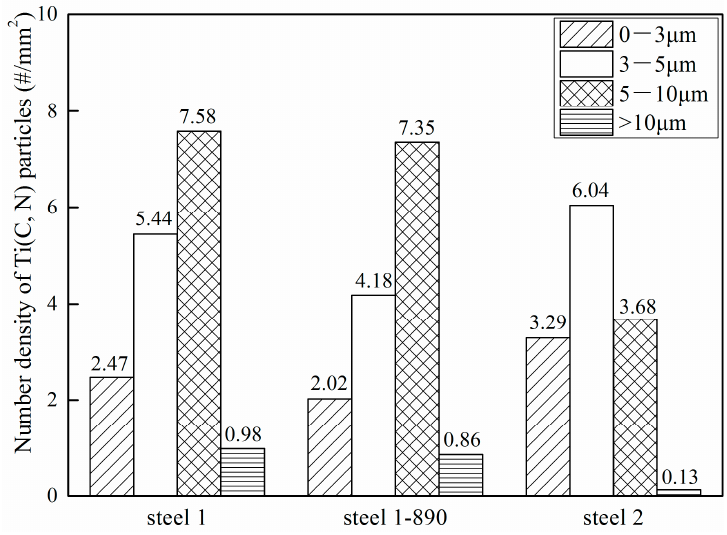
Figure 12. The size of Ti(C, N) particles in specimens.